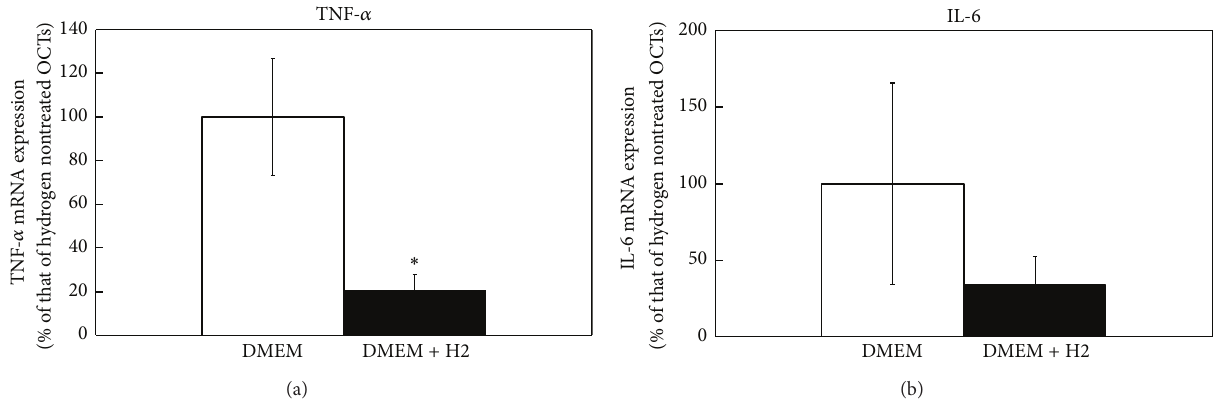
Figure 5: Real-time PCR analysis of OCTs cold-preserved in the presence and absence of supplemental hydrogen. Expression of TNF- 𝛼 (a) and IL-6 mRNAs (b) in H2-treated and nontreated DMEM groups. ∗ indicates a statistically significant difference between the H2-treated and nontreated DMEM groups. All data are shown as the mean ± SE ( 𝑛 = 6